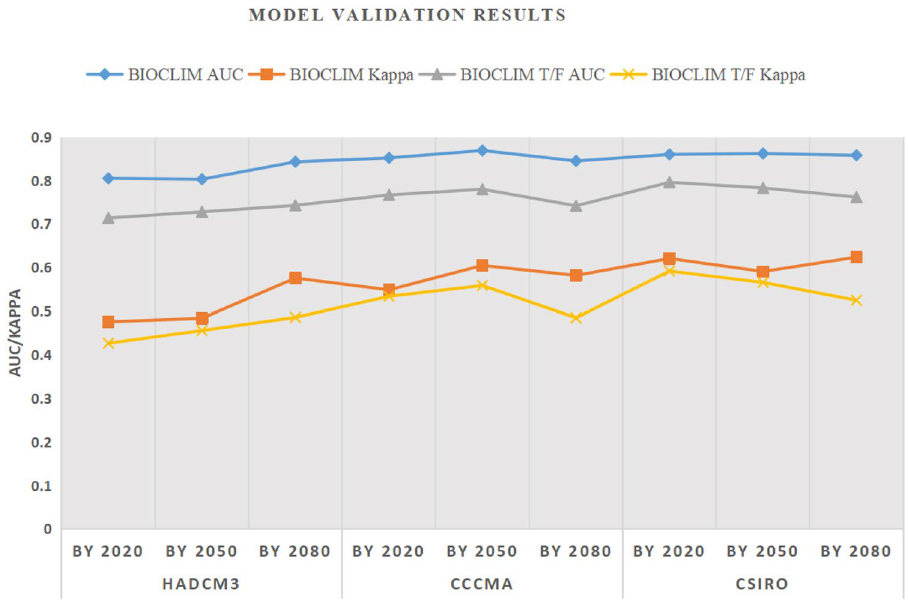
Fig. 5 Model validation results (AUC/ kappa ) for BIOCLIM and BIOCLIM True/False prediction models with future climate projection models HADCM3, CCCMA and CSIRO by 2020, 2050 and 2080. BIOCLIM model had higher sensitivity than BIOCLIM